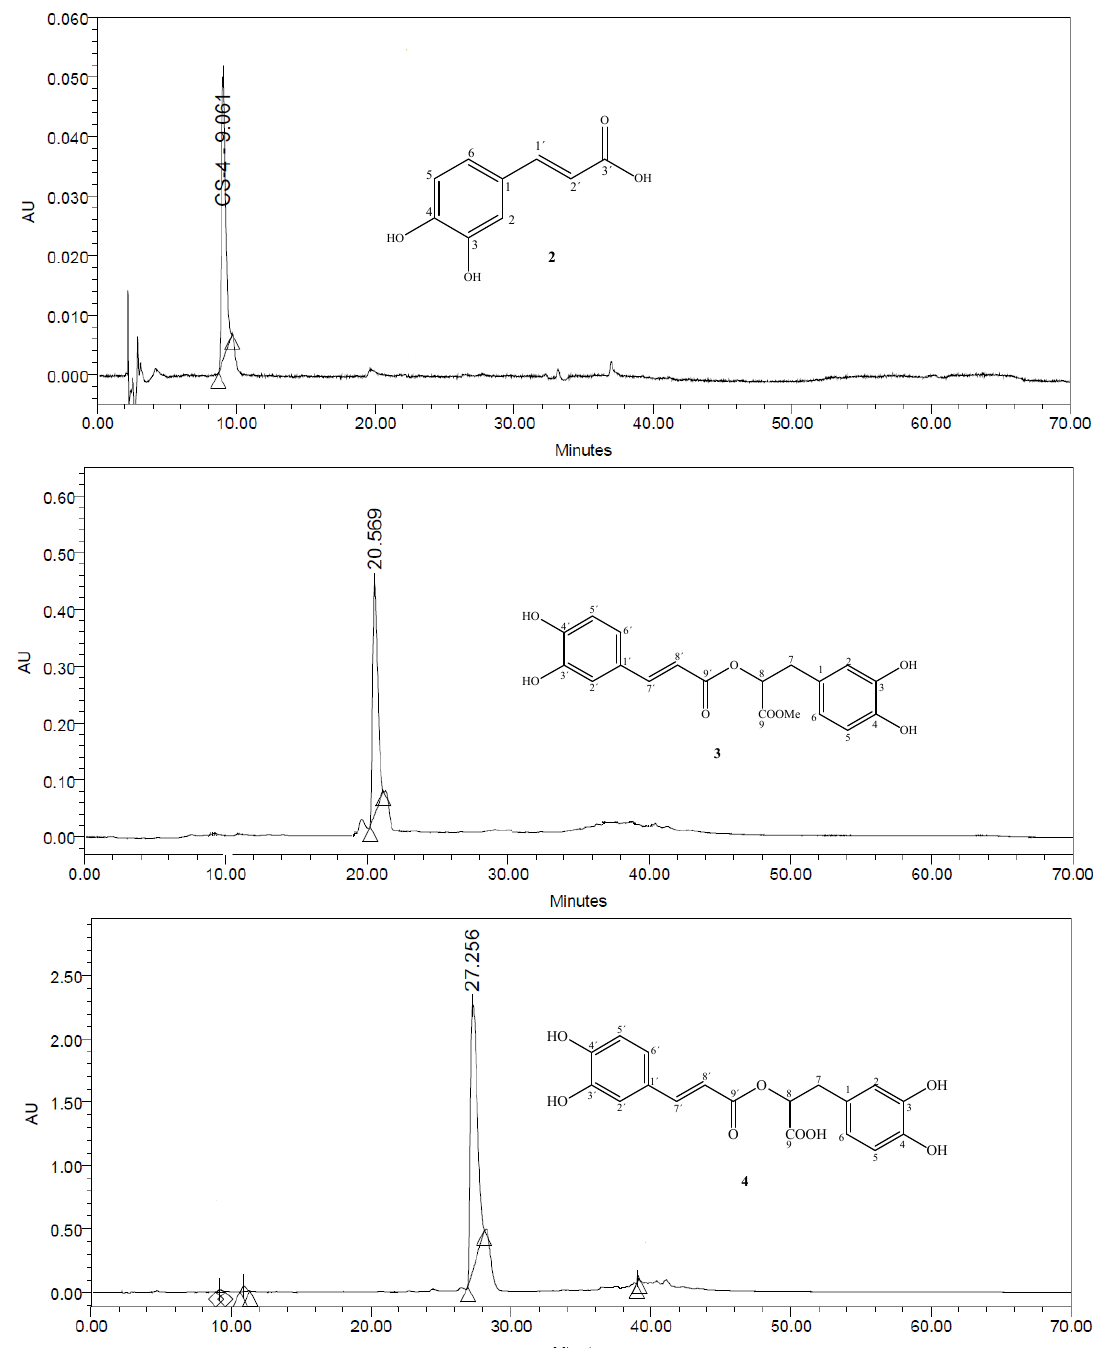
Figure 2. HPLC chromatograms of compounds 2–5 , 8 , 9